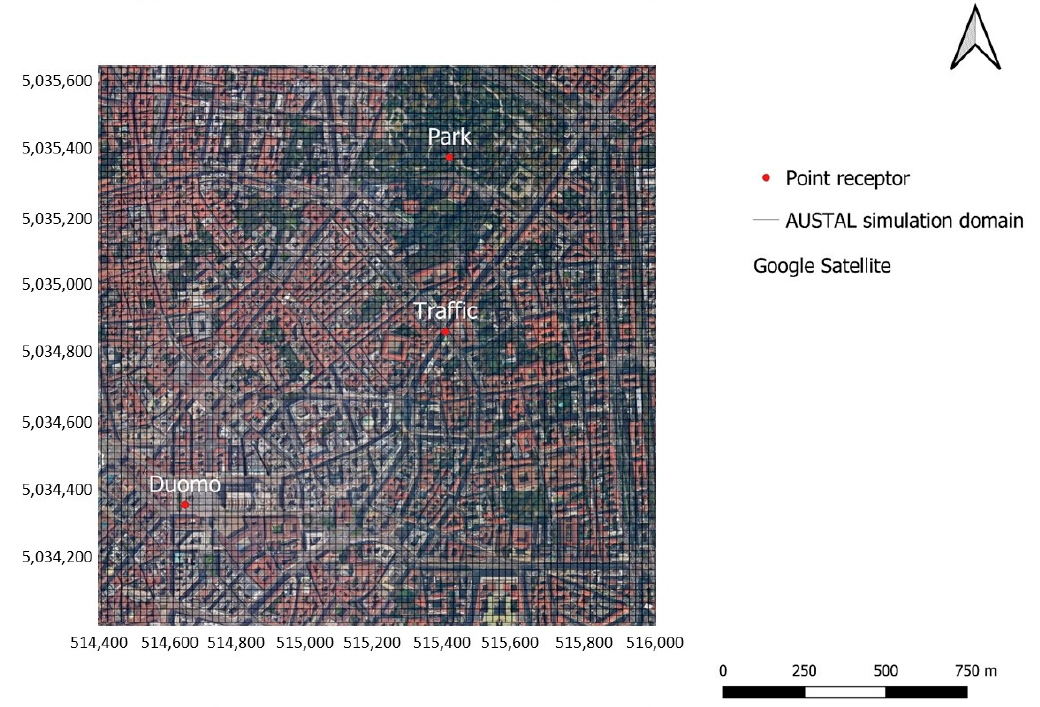
Figure 2. AUSTAL2000 computational domain over Milan city center and selected receptors location.